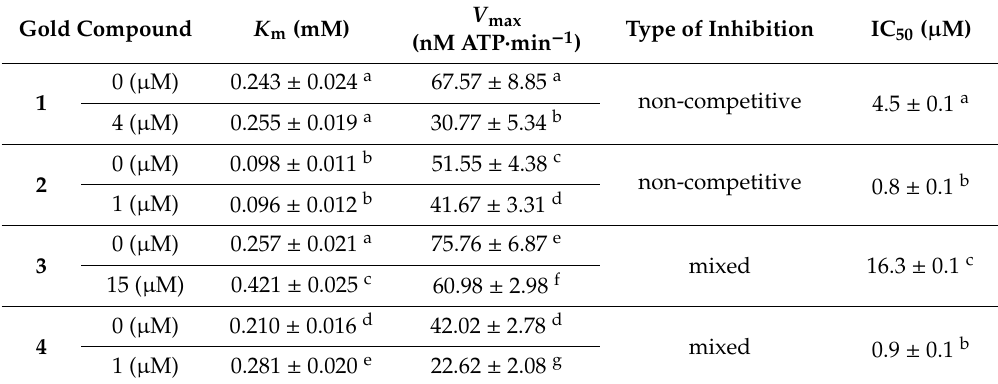
Table 1. K m , V max and IC 50 values of Ca 2+ -ATPase inhibition by gold compounds. Gold Compound